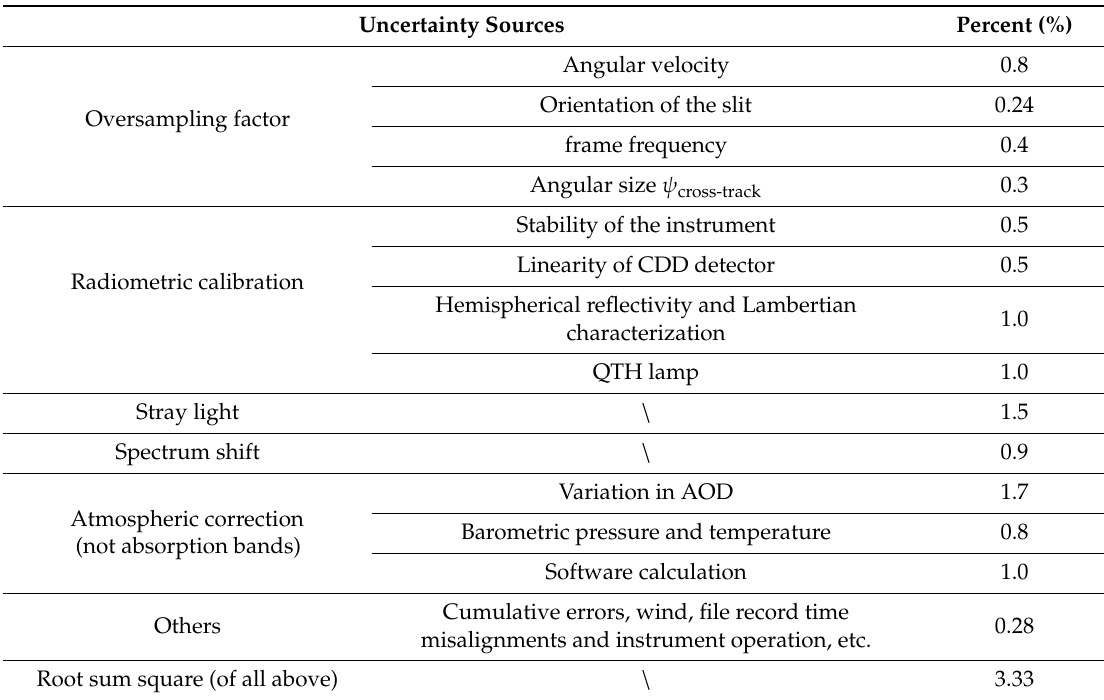
Table 4. Uncertainties tracked during data